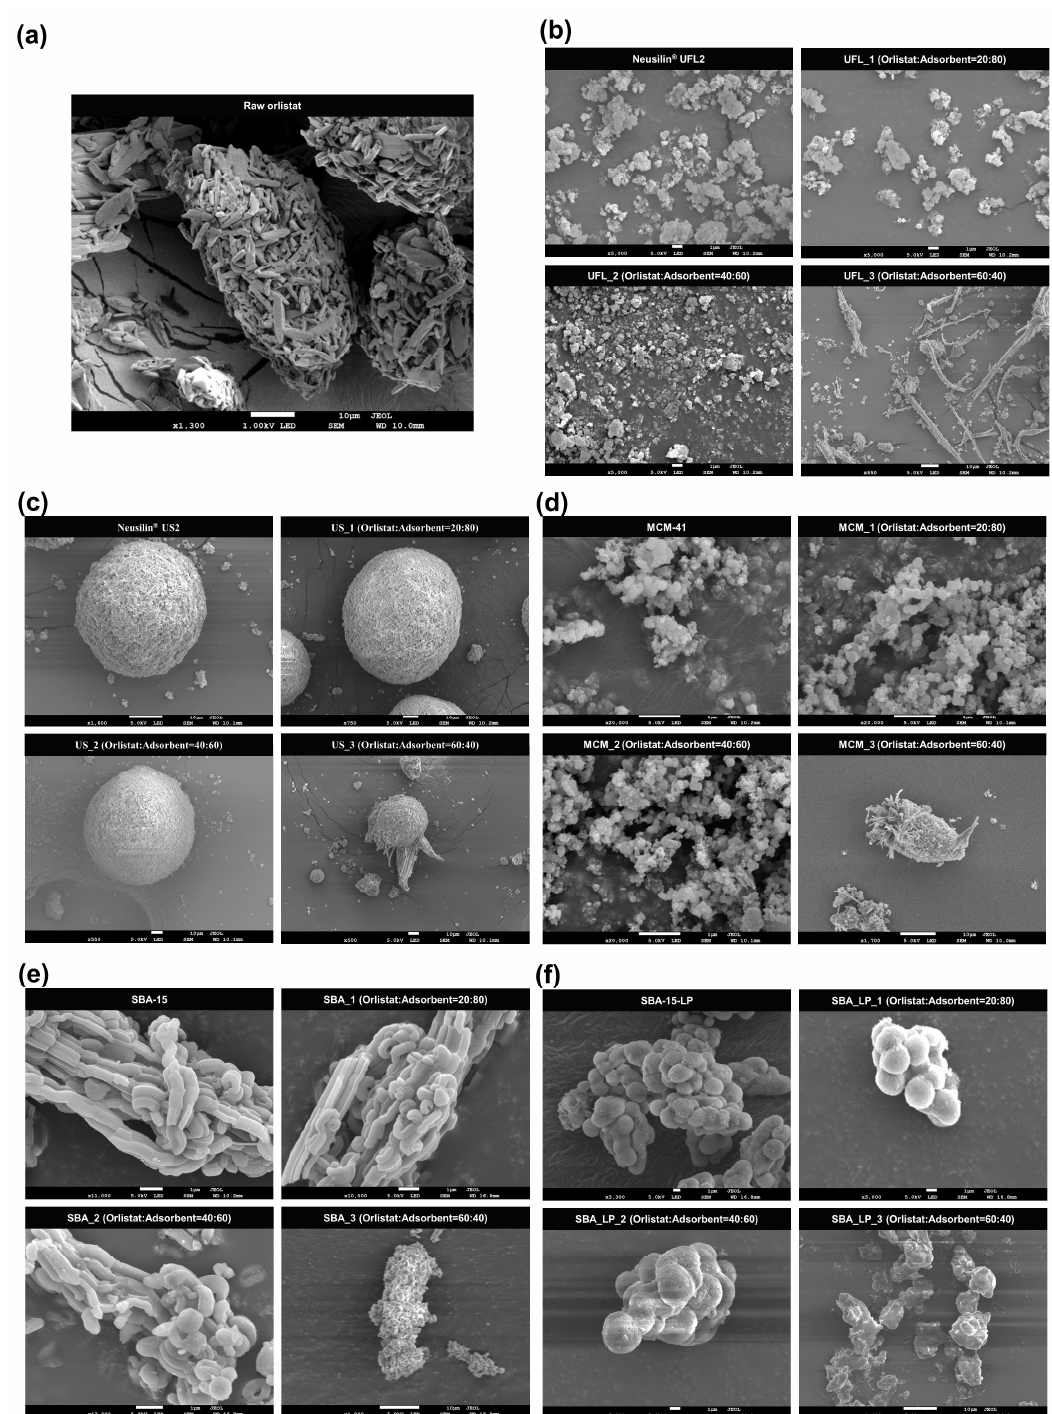
Figure 2. SEM images of particles with various raw mesoporous silica and orlistat adsorbed on them at three different drug loading ratio by SCMA process: ( a ) raw orlistat, ( b ) Neusilin ® UFL2; ( c ) Neusilin ® US2; ( d ) MCM-41; ( e ) SBA-15; and ( f ) SBA-15_LP.